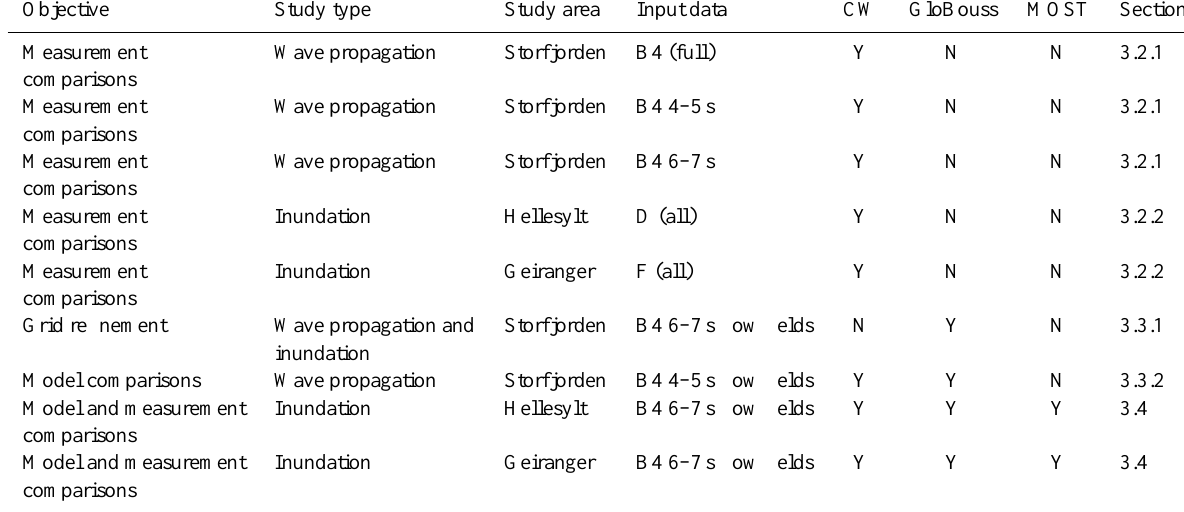
Table 1. Overview of the models, objective, source input data, and locations for the different case studies in this paper. The different studies comprised of measurement comparisons, grid refinement tests, and model comparisons. The abbreviation CW refers to Coulwave. Objective Study type